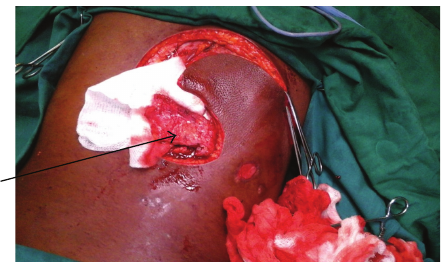
Figure 1: Gunshot wound with arrow pointing at the bullet exit.